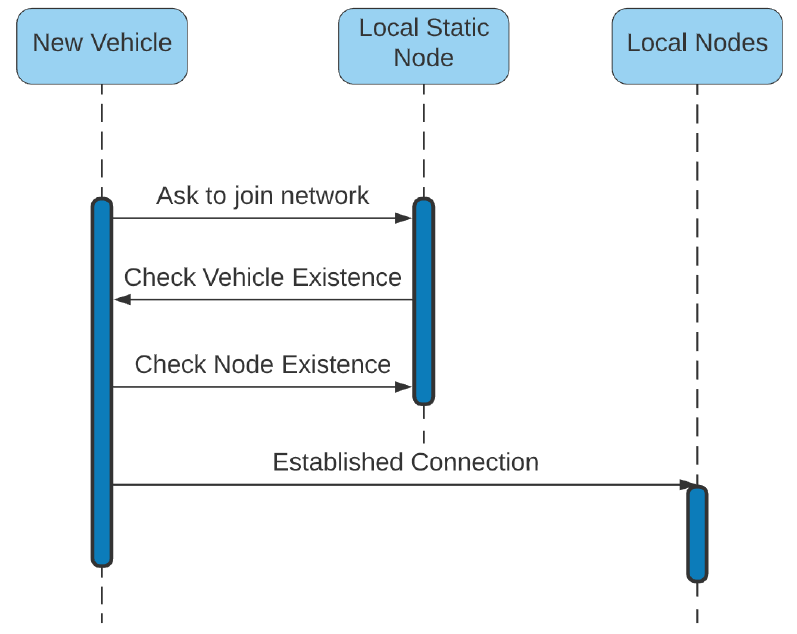
Figure 10. An example UML of a new vehicle entering a Smart City such as the one shown in Figure